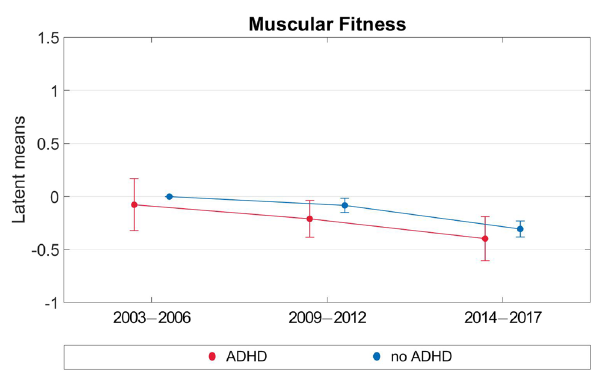
Figure 4. Multi-group analyses for development of muscular fitness